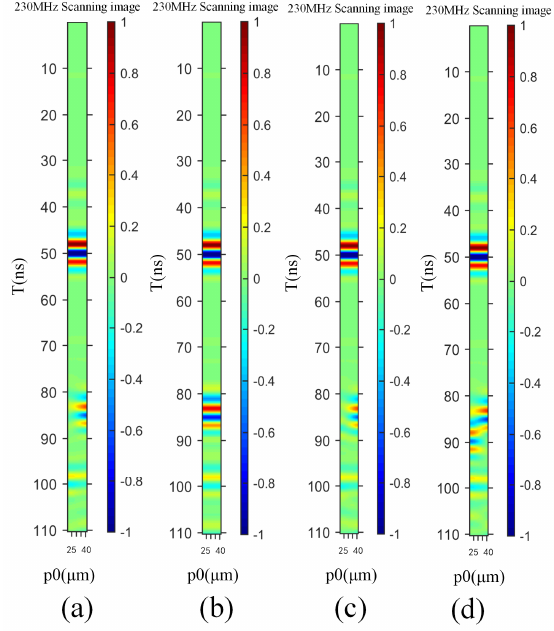
Figure 4. B-scan image of solder ball defects (( a ) defect-free, ( b ) ball missing, ( c ) void, and ( d ) crack).